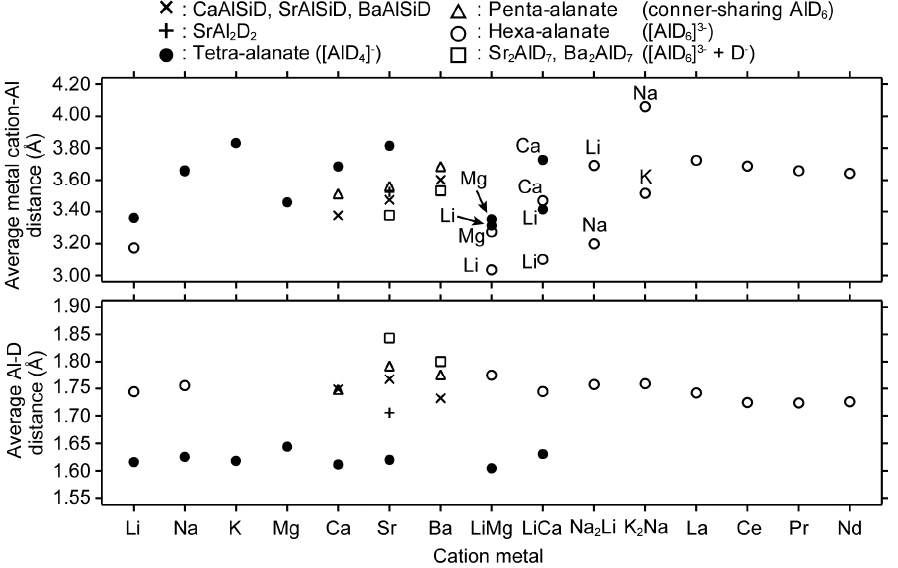
Figure 3. Metal cation dependences on (upper) average metal cation–Al and (lower) Al–D distances in alanates and related Al-based hydrides. The distances were obtained from their deuterides, except for Mg(AlH 4 ) 2 , LiCa(AlH 4 ) 3 , LiCaAlH 6 , K 2 NaAlH 6 , LaAlH 6 , CeAlH 6 , PrAlH 6 and NdAlH 6 (LiCa(AlH 4 ) 3 and LiCaAlH 6 are theoretical calculation results) [3,8–10,12–14,25–37] because their crystal structural investigations on deuterides have not been reported. Average metal cation–Al distance of Na 3 AlD 6 (3.65 Å) [33] is overlapped with NaAlD 4 (3.66 Å) [28]. In CaAlSiD, SrAlSiD, BaAlSiD and SrAl 2 D 2 , Ca, Sr and Ba were formally considered as their metal cation.